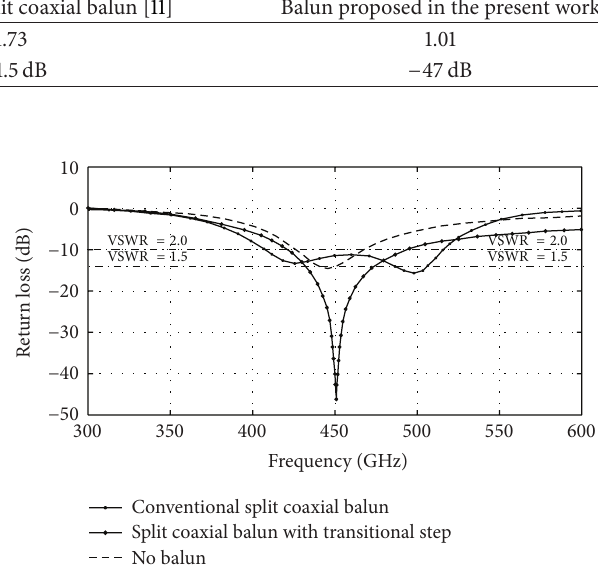
Table 2: Performance of different types of baluns used to feed a dipole antenna from a 50 Ω coaxial line. Performance measure